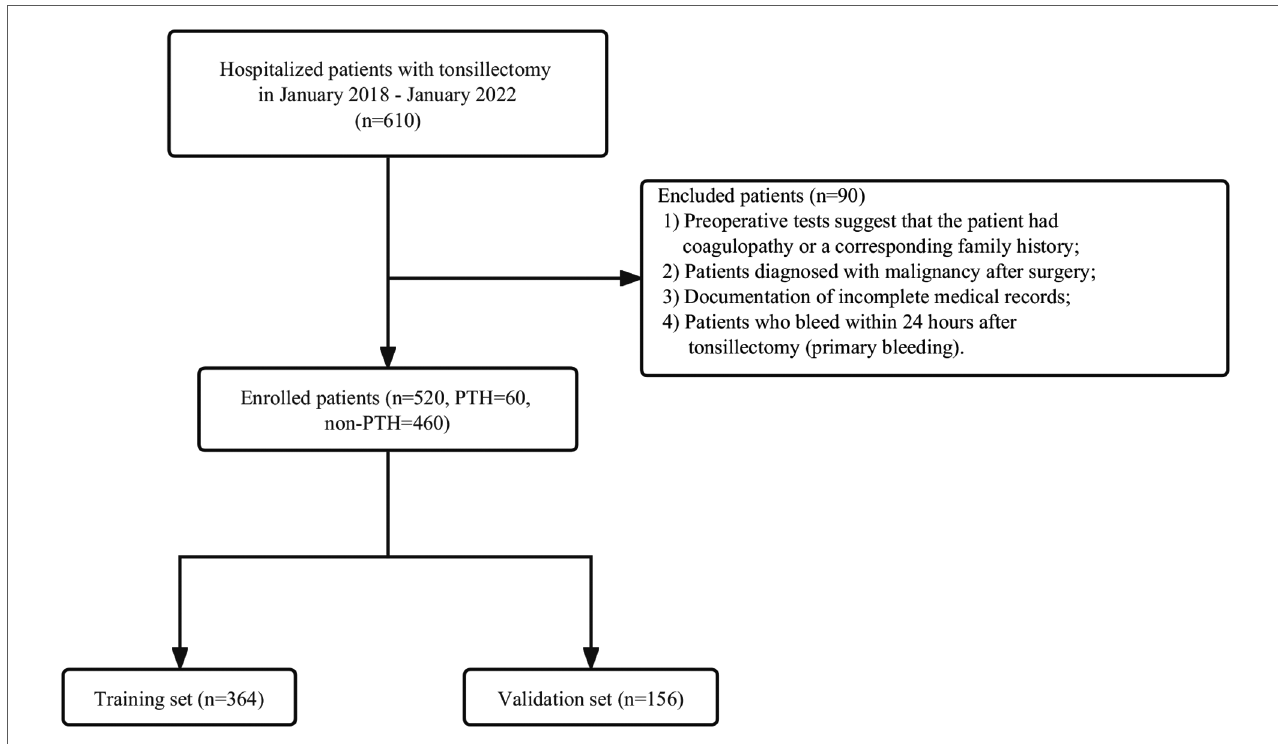
FIGURE 1 Flowchart of patient selection. Non-PTH, No Post-tonsillectomy hemorrhage; PTH, Post-tonsillectomy